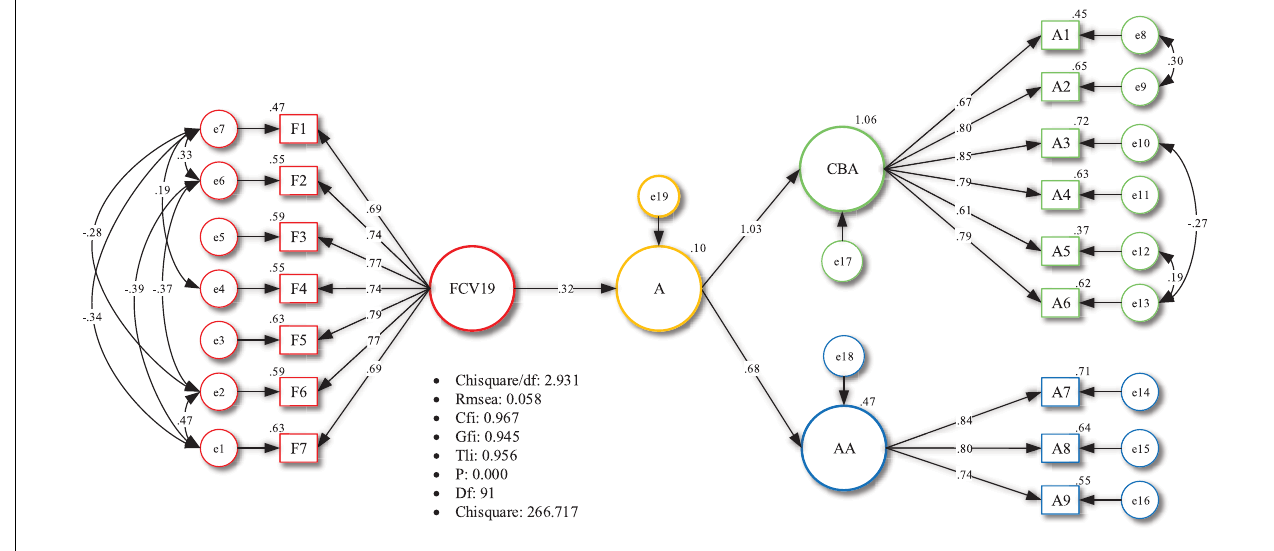
FIGURE 6 | Structural model results. TABLE 7 | Structural model path coefficients.